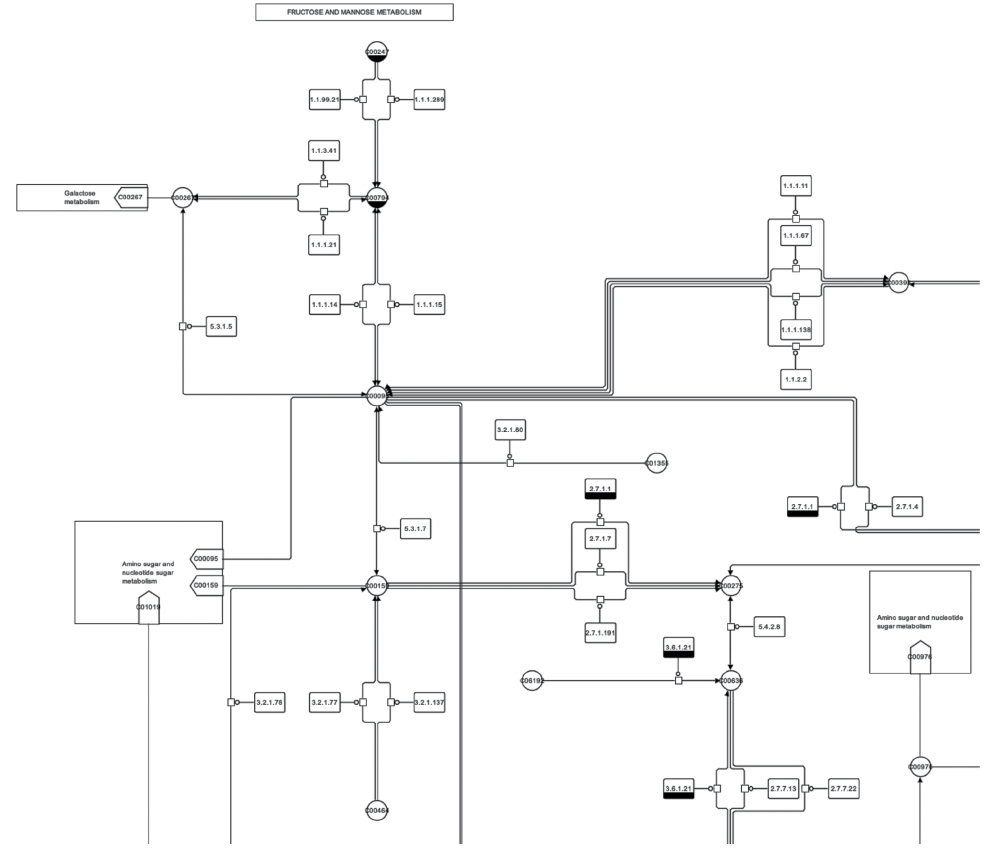
Figure 1: Typical visualisation of a metabolic network, in this case a cutoff of a metabolic pathway derived from KEGG [1]. The network is shown in the SBGN [2] representation computed by SBGN-ED [3], including automatic layout based on the original KEGG layout [4].